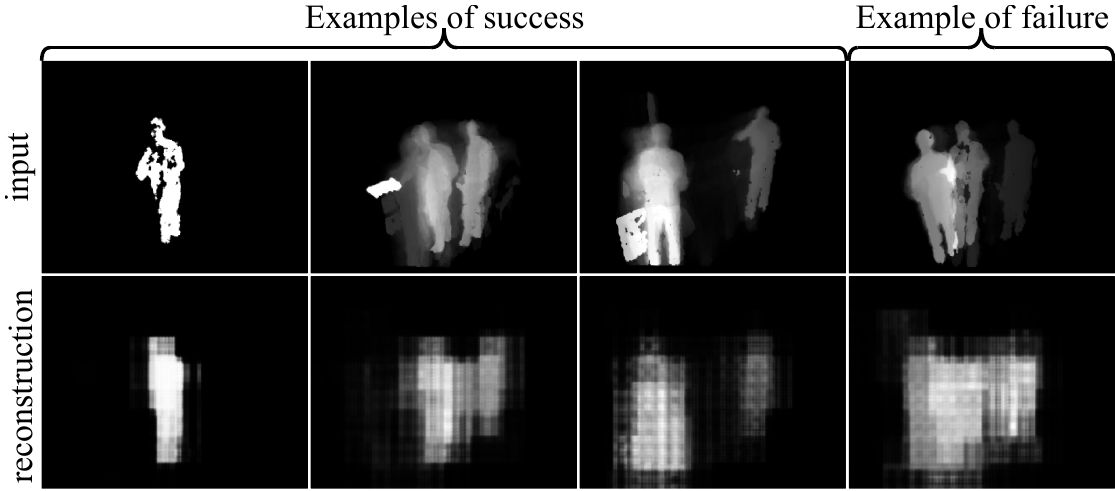
Figure 5. Successful ( first three columns ) and failure ( last column ) examples for the silhouette VAE to reconstruct both spatial and temporal information in the input. The first and second rows show the silhouette inputs and their corresponding reconstructions,